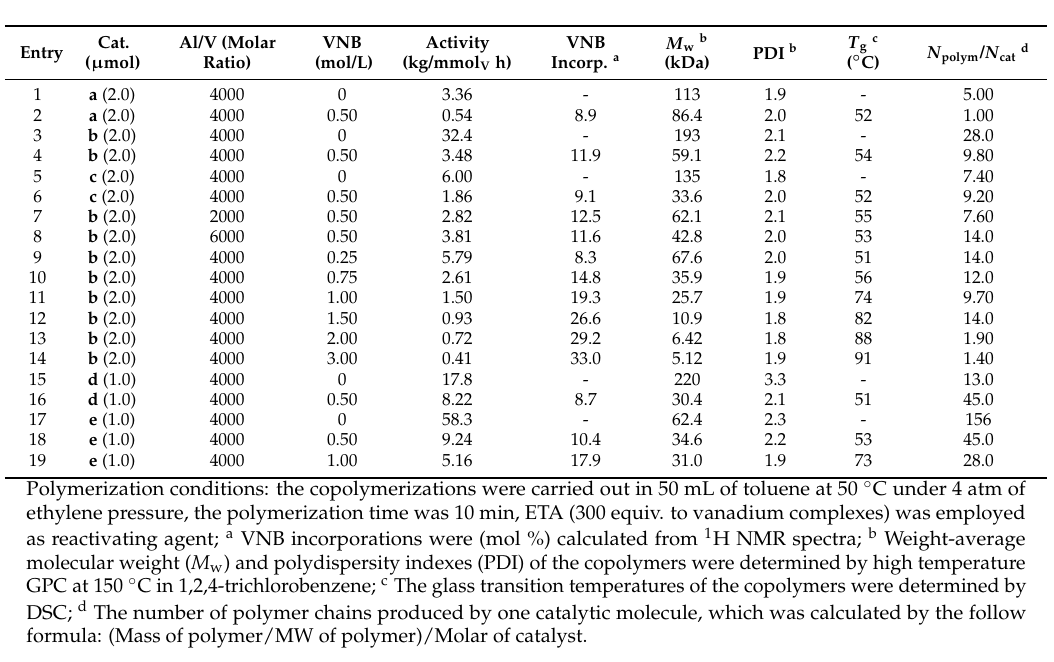
Table 1. Ethylene/VNB copolymerization by oxovanadium(V) complexes.